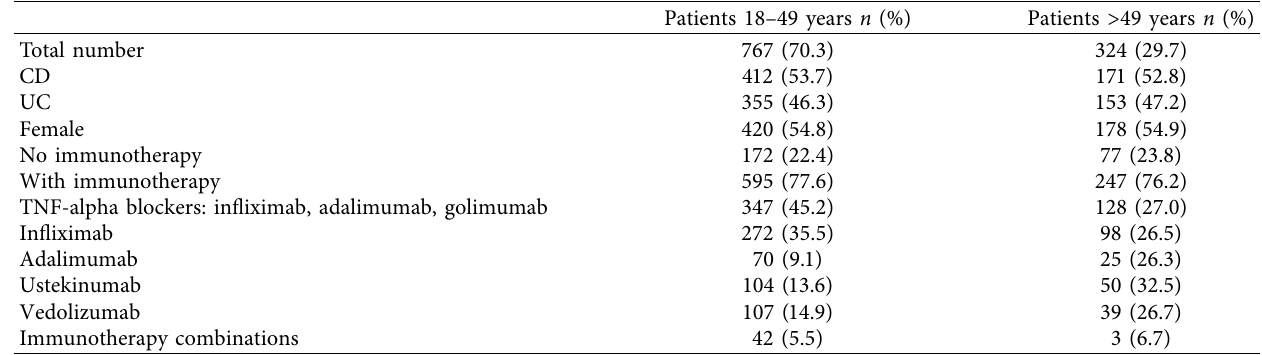
Table 3: Patients’ characteristics of young versus old patients.